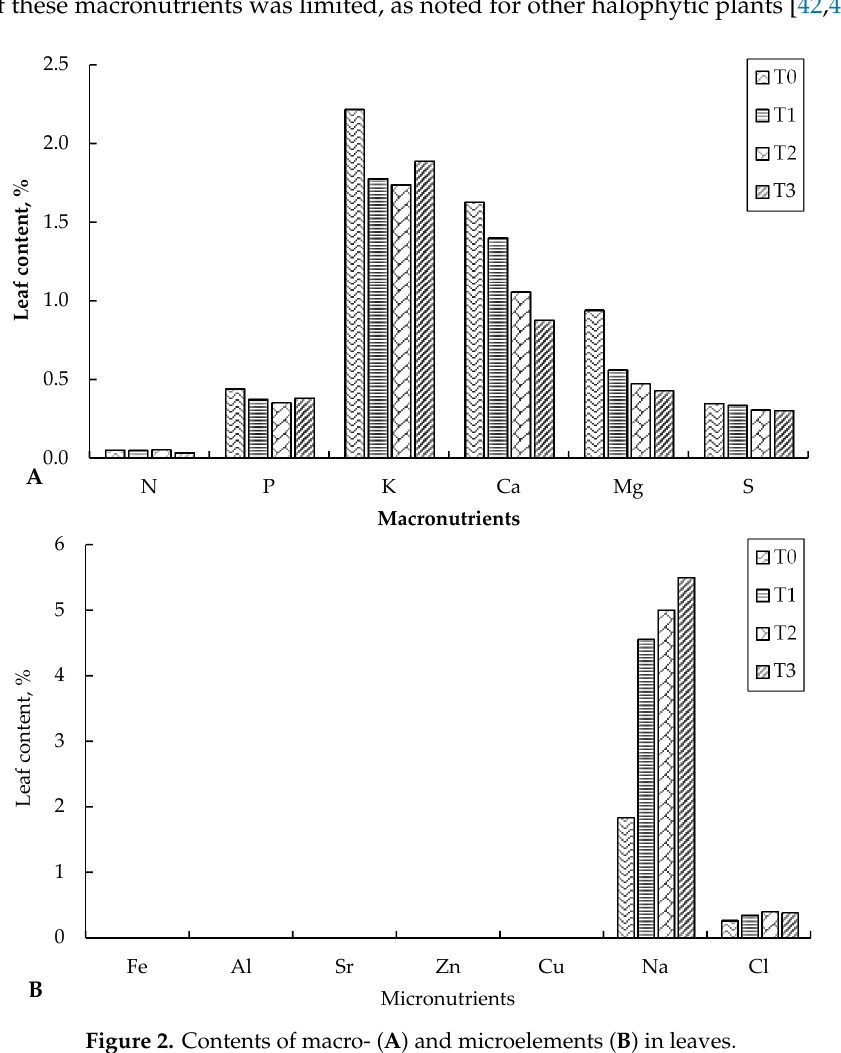
Figure 2. Contents of macro- ( A ) and microelements ( B ) in leaves.